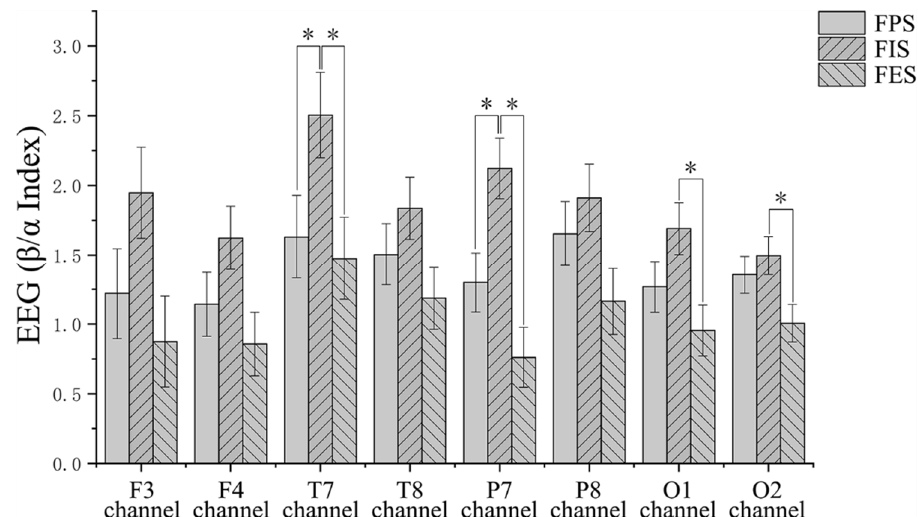
Figure 6. EEG ( β / α index) values among the three groups ( N = 20; mean ± standard error; * p < 0.05; ** p < 0.01).